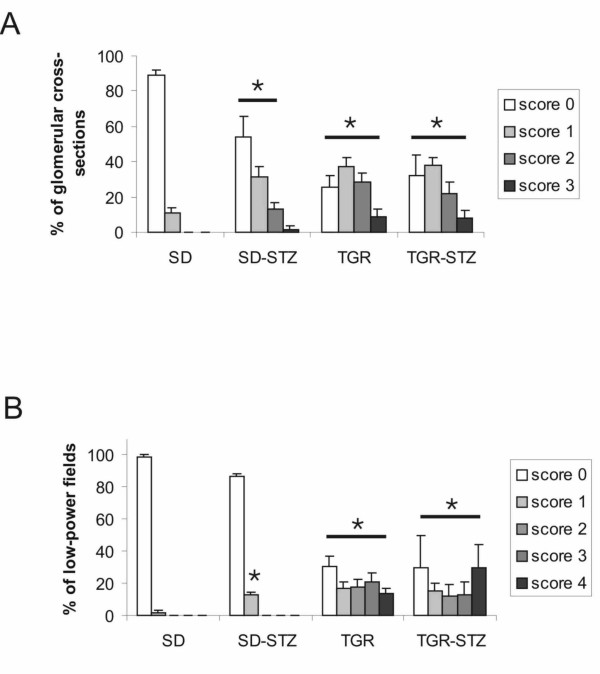
Semiquantitative evaluation of MCP-1 immunohistochemistry. For glomerular staining (A) more than 100 glomeruli per kidney section were classified 0 to 3 (see methods and figure 5 for details). The percentage of glomeruli assigned to a given score value is shown. For interstitial MCP-1 scores (B), 20 low-power cortical fields were classified 0 to 4 (see methods for details). The percentage of interstitial fields assigned to a given score value is shown. SD, normotensive normoglycemic control rats; TGR, transgenic hypertensive rats; STZ, streptozotocin treatment. Data are mean ± SEM of n = 5 rats. * indicates p < 0.05 versus normotensive normoglycemic Sprague-Dawley (SD) control rats.